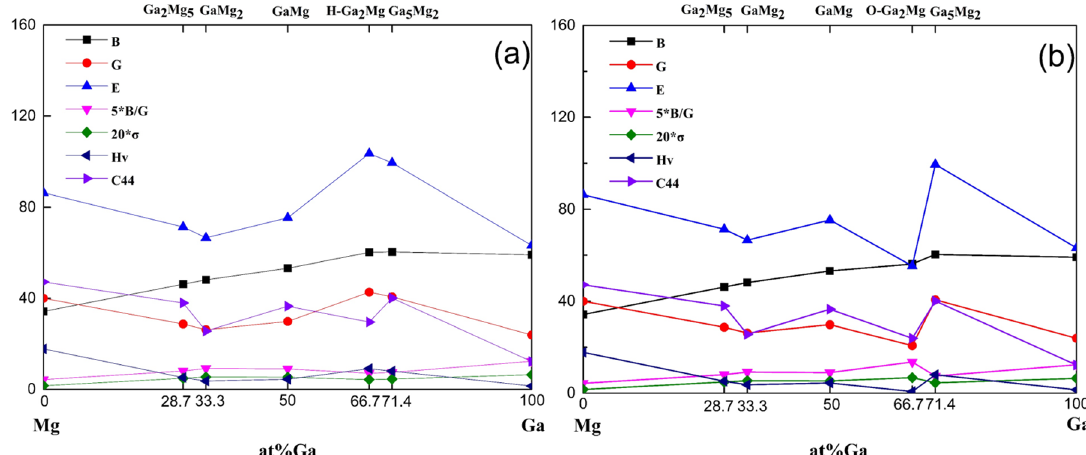
Figure 4. The variations of the elastic parameters of Ga-Mg compounds, note that B/G value is magnified by 5 times and σ value is magnified by 20 times to the initial